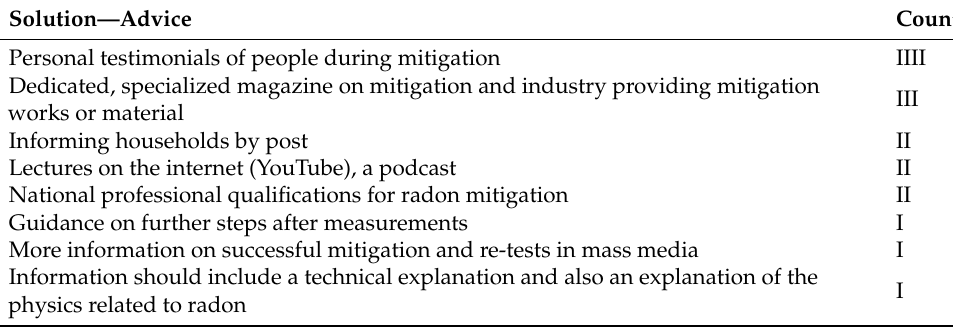
Table 5. Slovenia: solution statements advice about mitigation—converging.